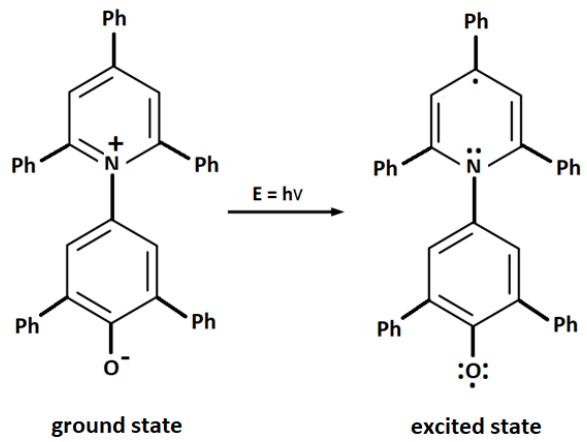
Figure 2. Reichardt’s betaine (own drawing based on [14]).